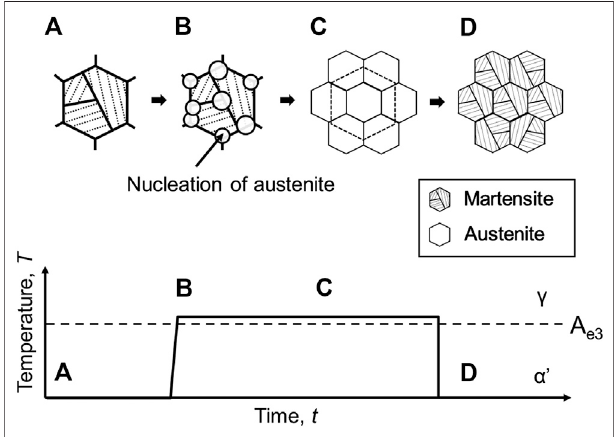
FIGURE 5 | Schematic illustrations showing the process of austenite grain re fi nement in the cyclic heat treatment.